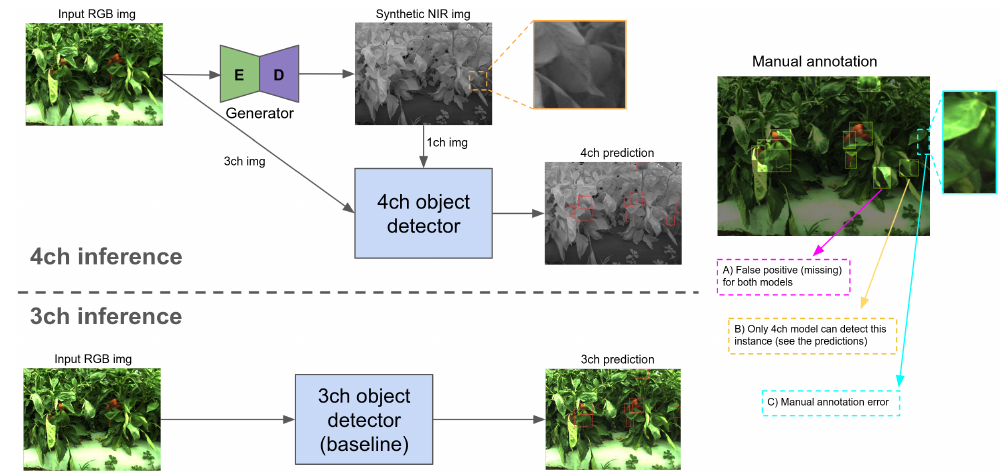
Figure 8. The 4-channel(ch) early fusion object detection inference pipeline ( top ) and 3-channel ordinary inference ( bottom ). Brighter areas in manual annotation on the right image indicate manual labeled bounding boxes. One can compare them with model predictions (i.e., red boxes in ‘4ch prediction’ and ‘3ch prediction’). This image best viewed zoomed-in.